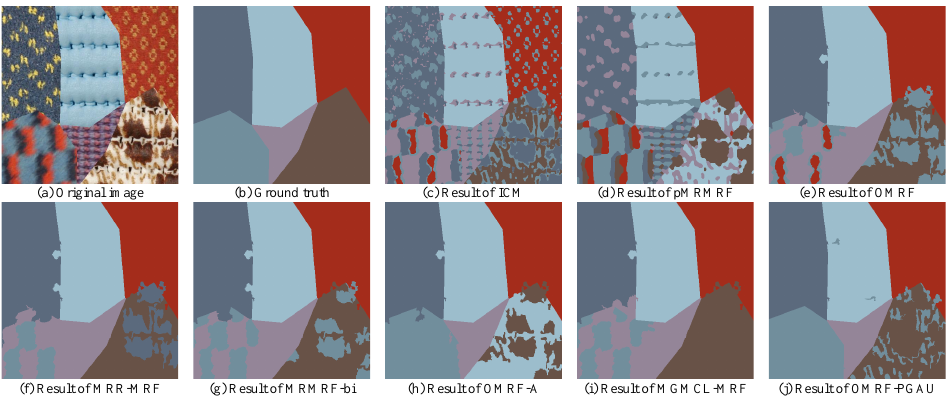
neighborhood only contains eight surrounding pixels, the spatial relationship considered is relatively narrow, so the segmentation result is obviously misclassified. Because MRMRF constructs a multi-resolution layer structure, a larger range of spatial relationships can be considered, so the segmentation results have been improved. Several object-level methods use over-segmented regions as nodes in the probability graph, so the regional consistency of the segmentation results is better, and the completeness of each category of the segmentation results is higher. Among them, MRR-MRF and MRMRF-bi combine object-level idea and multi-resolution scales to significantly improve the segmentation of urban parts. OMRF-A and MGMCL-MRF use multiple label fields to segment the airstrips part more completely. OMRF-PGAU uses the partitioning-the overall alternate update mechanism, combined with the advantages of the auxiliary label field, so that the segmentation accuracy of towns, snow-capped mountains and airstrips is better.